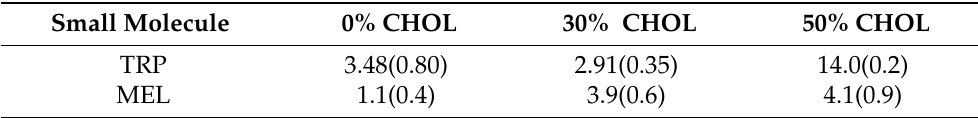
Table 4. Self diffusion coefficients D (in 10 − 7 cm 2 /s) of TRP and MEL in systems with different cholesterol percentages. The estimated errors are in